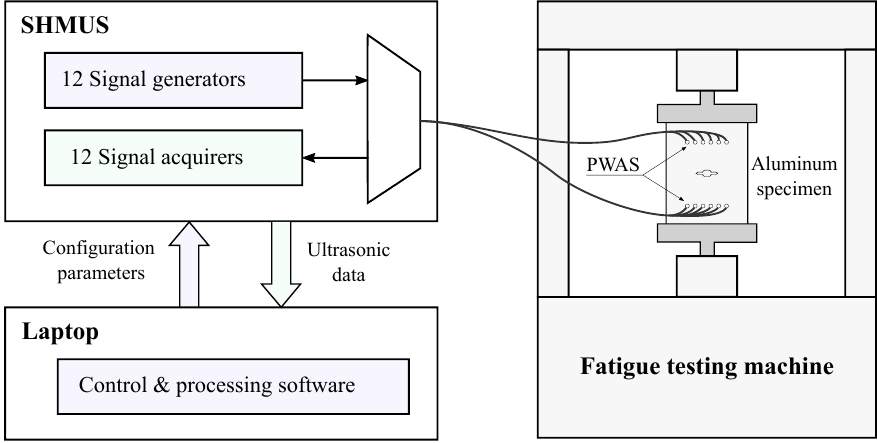
Figure 4. Schematic of the ultrasonic guided-wave based